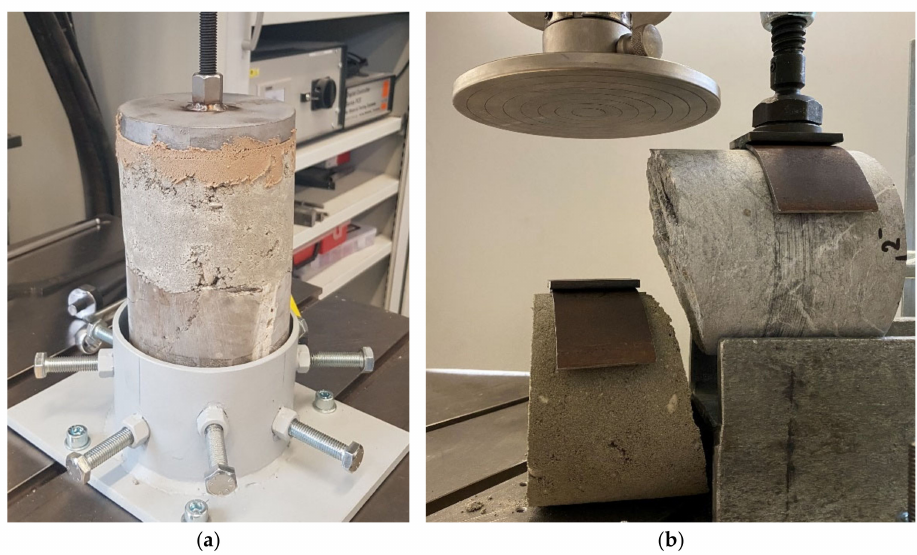
Figure 6. Determination of the adhesive tensile strength ( a ) and adhesive shear strength ( b ) after failure on mortared limestone drill cores.